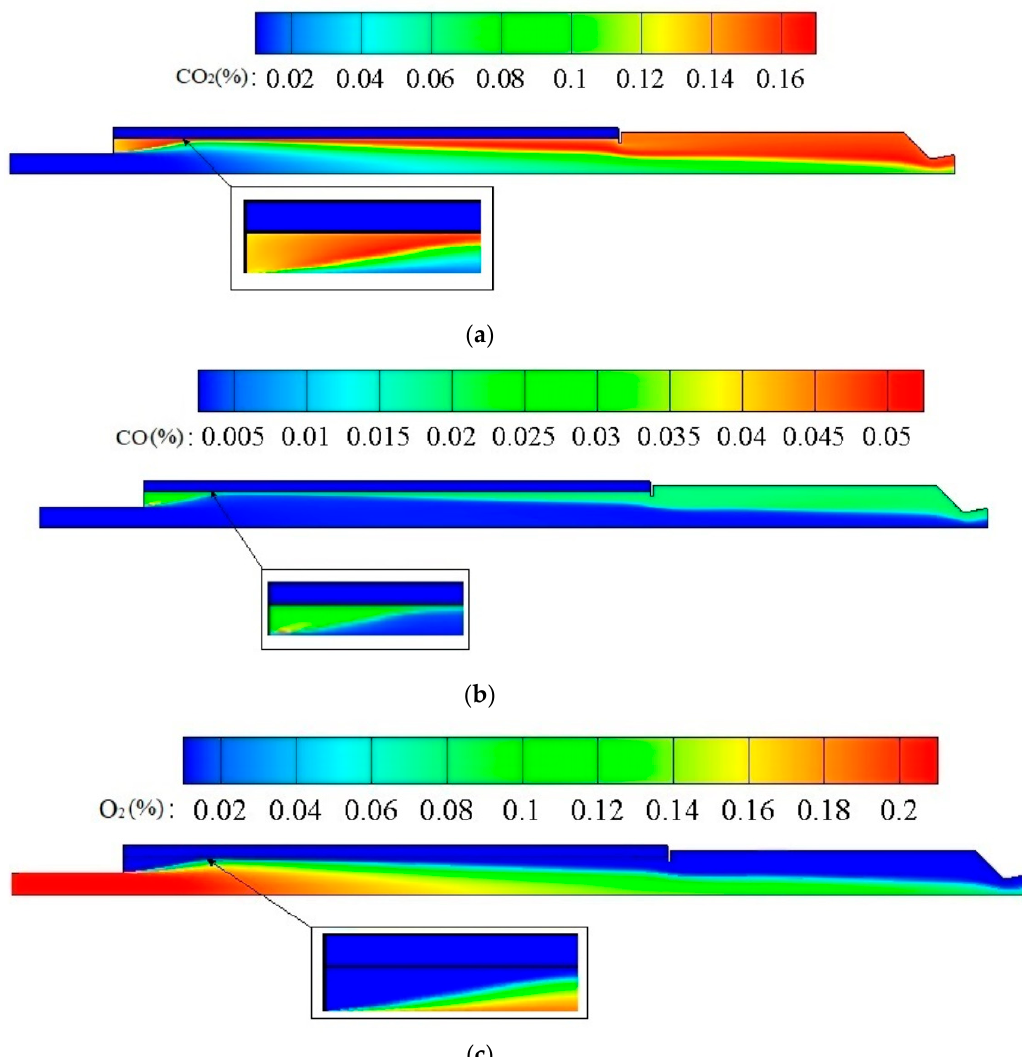
Figure 16. The contour of temperature and streamline.